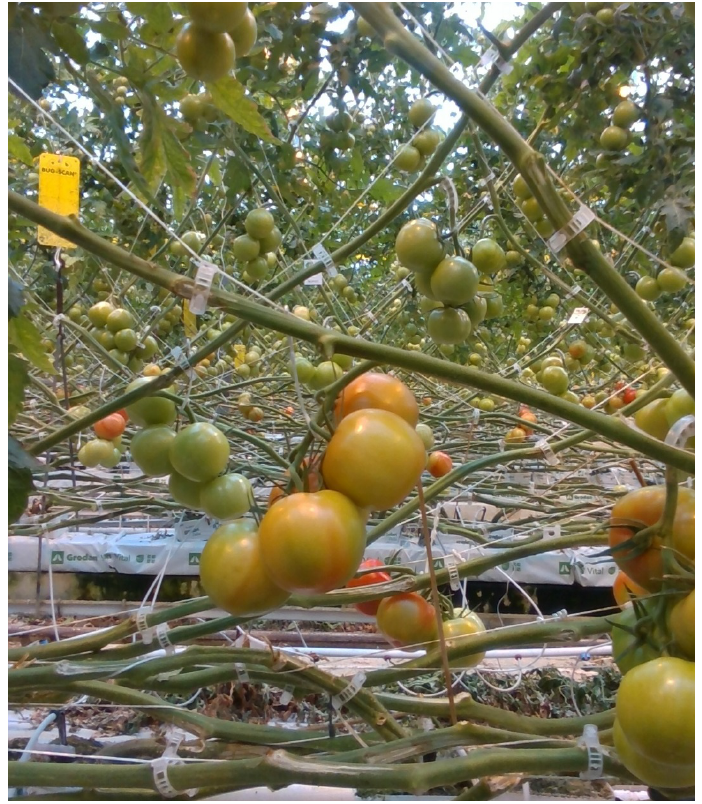
Figure 2. An image from a commercial tomato